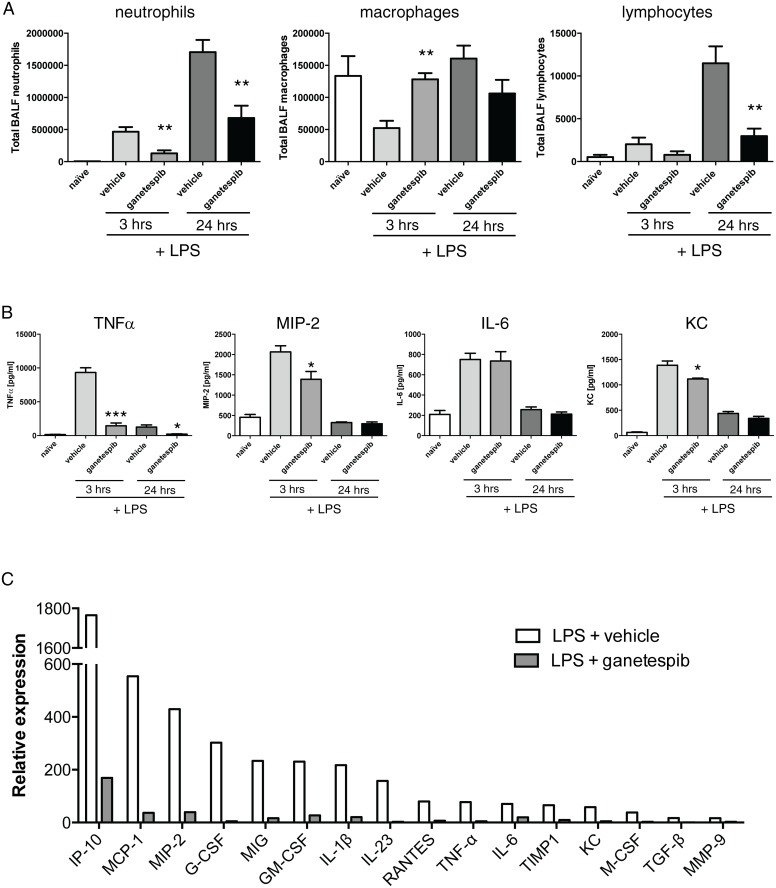
Effect of Ganetespib on cellular inflammation and mediator levels and transcripts.
(A) Balb/c mice were treated with Ganetespib (50 mg/kg, i.v. or vehicle) and challenged with LPS (10 µg/mouse tn). BALF was collected at 3 and 24 h post-LPS and total cells/mL were counted and cellular composition was determined by manual counting microscopy using standard morphological criteria. Data are mean ± SEM. n = 8 mice per group for treatments, n = 4 naïve control. ** p < 0.01, *** p < 0.001 compared to LPS/vehicle treated mice. (B) Balb/c mice were treated with Ganetespib (30 mg/kg, i.v. or vehicle) and challenged with LPS (10 µg/mouse, tn). ELISA data for TNFα, MIP-2, IL-6 and KC in BALF obtained at 3 and 24 h (LOD 15.6 pg/ml). Data are mean ± SEM. n = 8 mice per group and n = 4 naïve control. * p<0.05, *** p<0.001 compared to LPS/vehicle treated mice. (C) Relative mRNA transcript abundance for a panel of inflammatory mediators measured in pooled lung tissue (n = 2–3 mice per group) collected 3 h post LPS. Expression is normalized to naïve control levels. Pooled samples, no statistics.